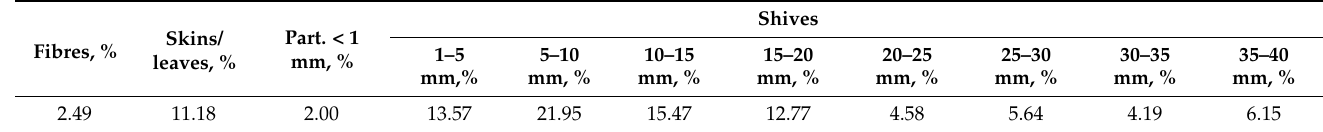
Table 2. Hemp particle size